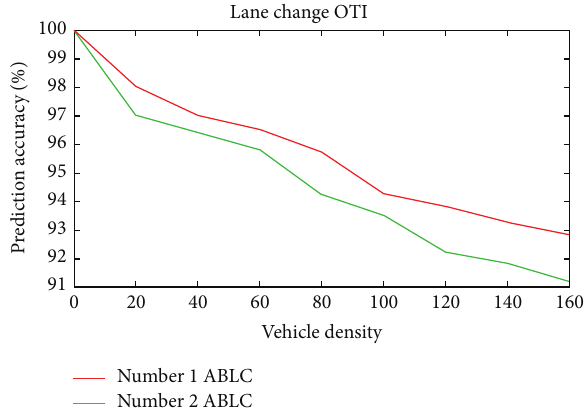
Figure 14: Prediction accuracy versus vehicle density for Scenario 3( b )